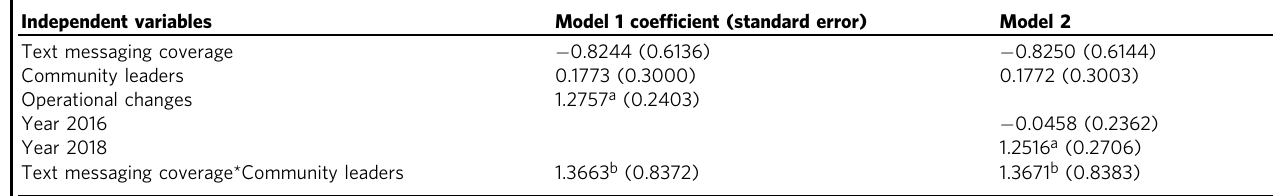
Table 2 Regression models analysing the effect of the operational changes on participation, with estimated vaccination coverage as the dependent variable (as per Table